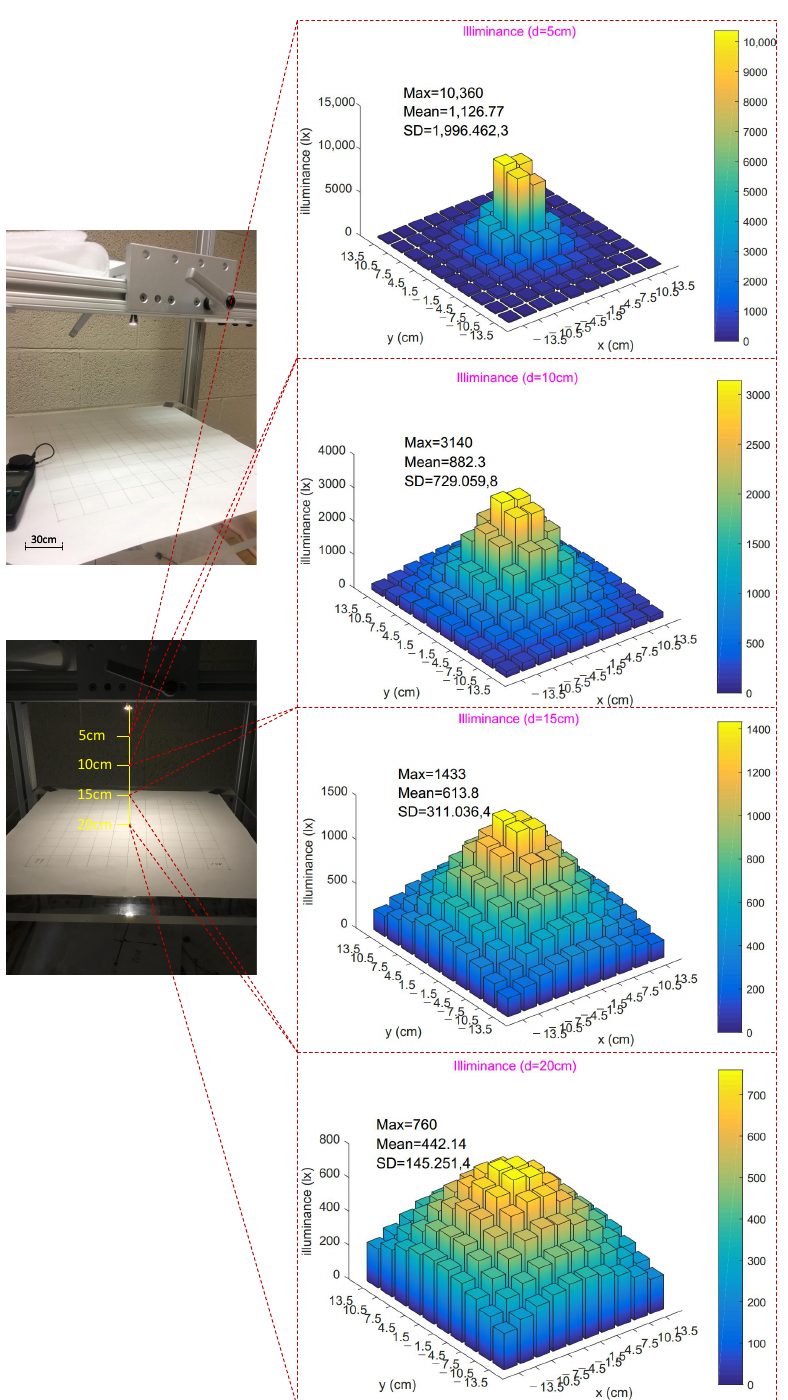
Figure 14. Illuminance tests at different distances to the LED